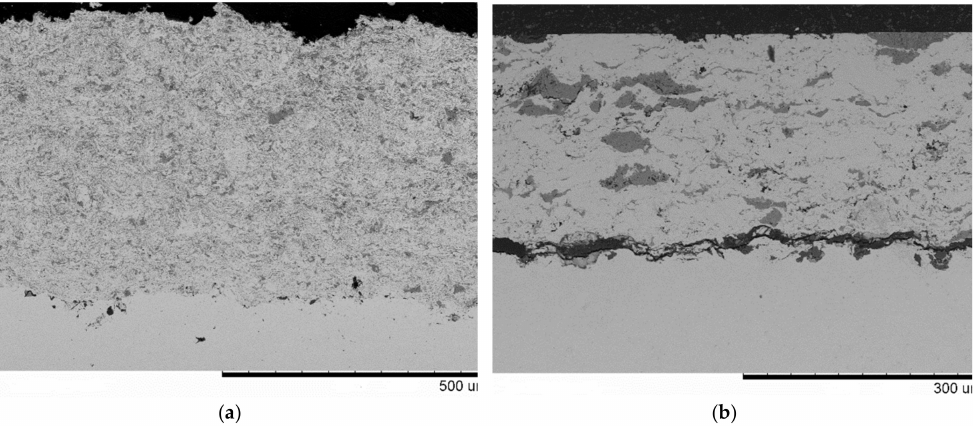
Figure 11. Cross-sections of the coatings produced by detonation spraying of 20 vol. % Ti 3 SiC 2 -Cu powders at an explosive charge of 30%, k = 1.5: ( a ) ball-milled mixture and ( b ) mixed in a mortar